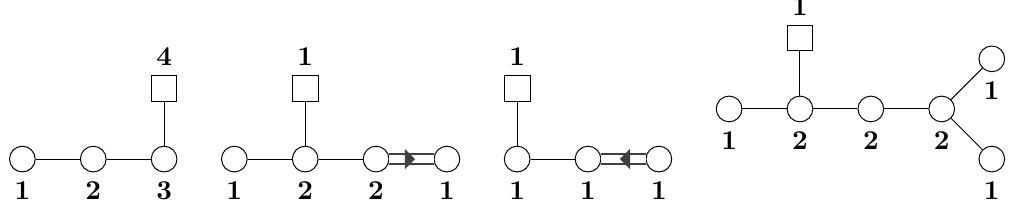
Figure 1 . Examples of balanced quivers of type A , B , C , resp. D